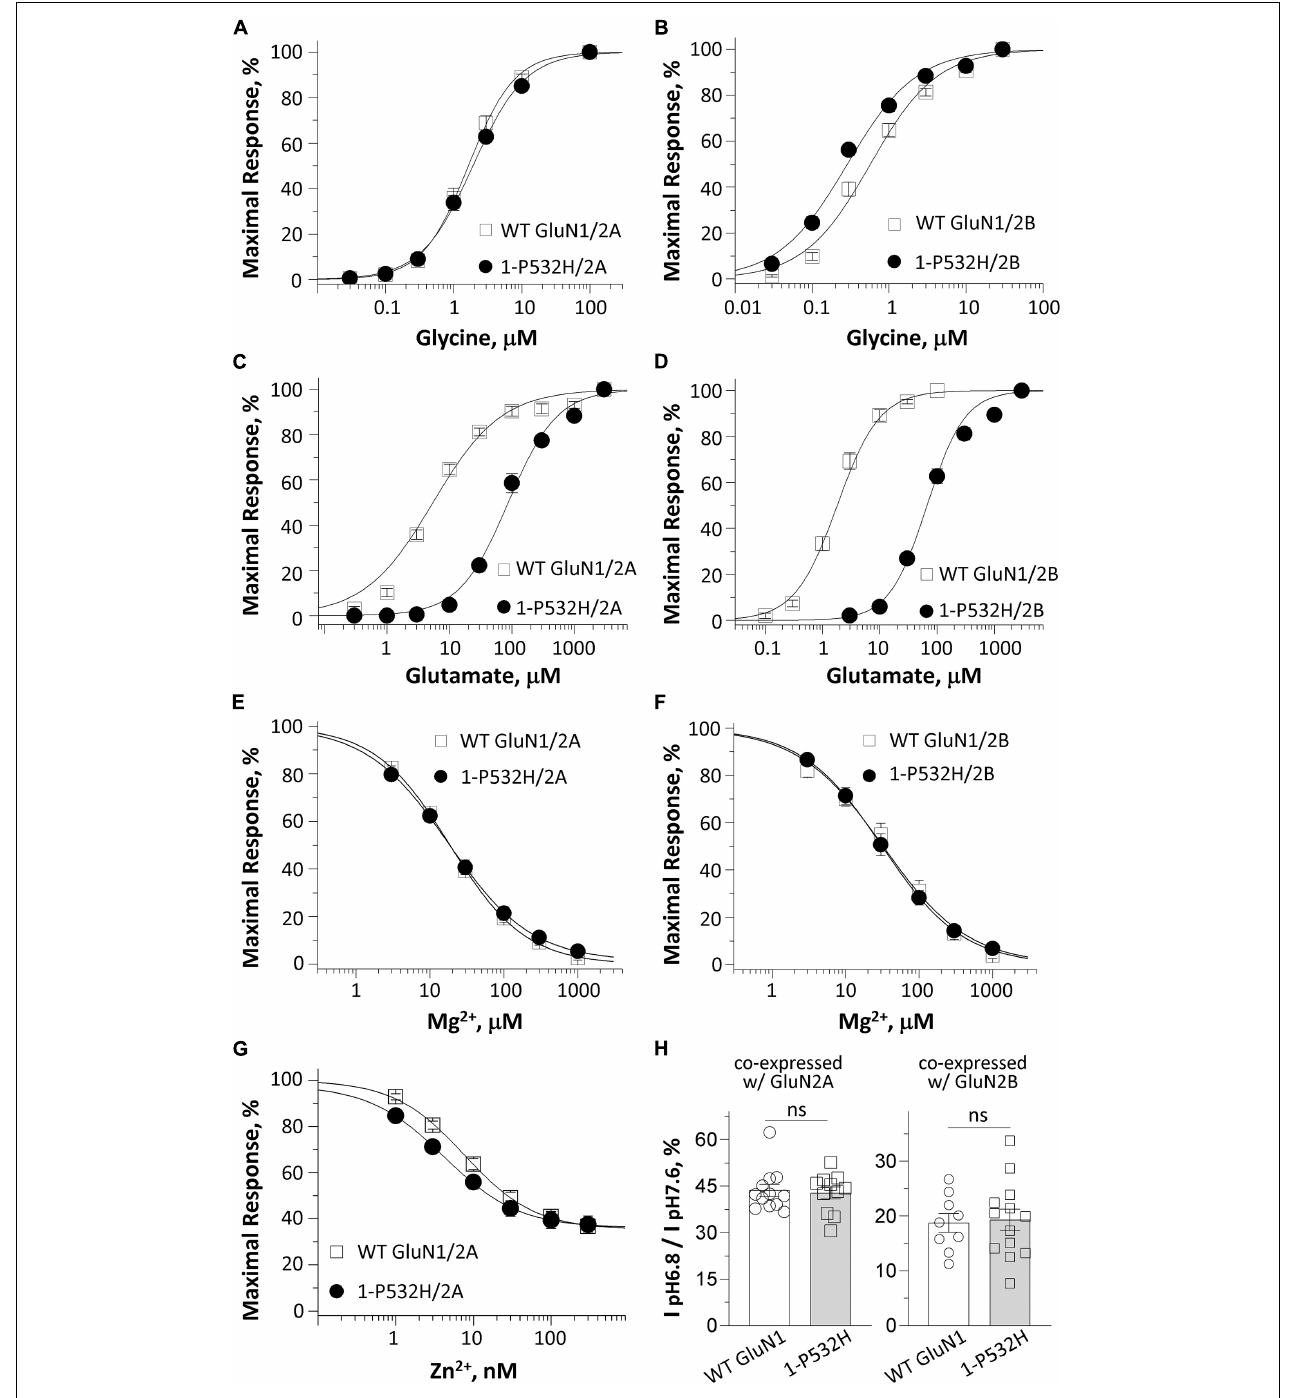
FIGURE 2 | Effects of GluN1-P532H variant on agonist potency and sensitivity to negative endogenous modulators. (A–D) Composite concentration–response curves determined by TEVC recordings from Xenopus oocytes are shown for WT GluN1 or GluN1-P532H coexpressed with GluN2A ( left panels ) or GluN2B ( right panels ). Glycine (in the presence of 1,000 µ M glutamate; A,B ) and glutamate (in the presence of 100 µ M glycine; C,D ) concentration-effect curves showed that the GluN1-P532H variant has reduced glutamate potency (increased EC 50 values; see Table 1 ) with a mild or no change in glycine potency. (E,F) Concentration–response curves for WT GluN1 and GluN1-P532H coexpressed with GluN2A (E) and GluN2B (F) receptors at a holding potential of –60 mV revealed no change in inhibition by extracellular Mg 2 + . (G) Composite inhibitory concentration–response curves for Zn 2 + at a holding potential of –20 mV showed enhanced inhibition by Zn 2 + (decreased IC 50 values, see Table 1 ). (H) Percentage of current at pH 6.8 compared with pH 7.6 in the GluN1-P532H/GluN2A receptors ( left panel ) and GluN1-P532H/GluN2B receptors ( right panel ) indicated the variant has no effect on proton sensitivity.